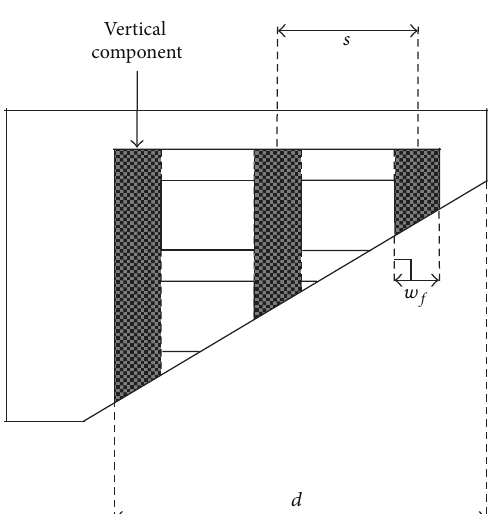
Figure 6: Definitions of 𝑤 𝑓 , 𝑑 , and 𝑠